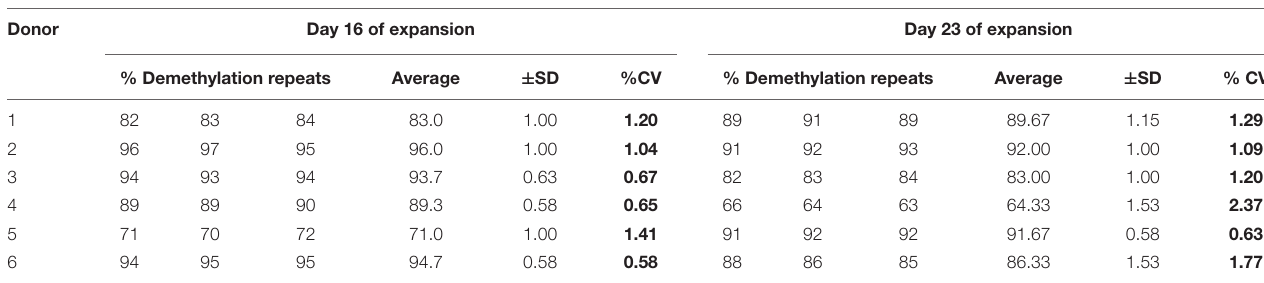
TABLE 2 | Reproducibility of the qddMSP